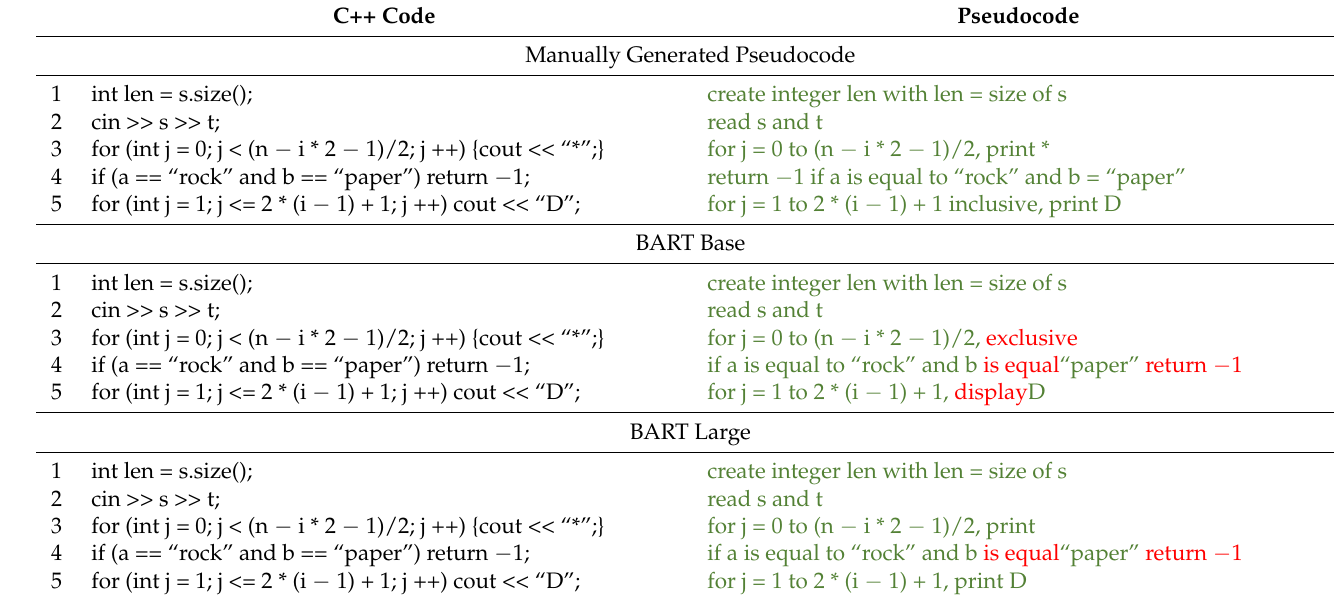
Table 4. The output of BART base and BART large for SPoC